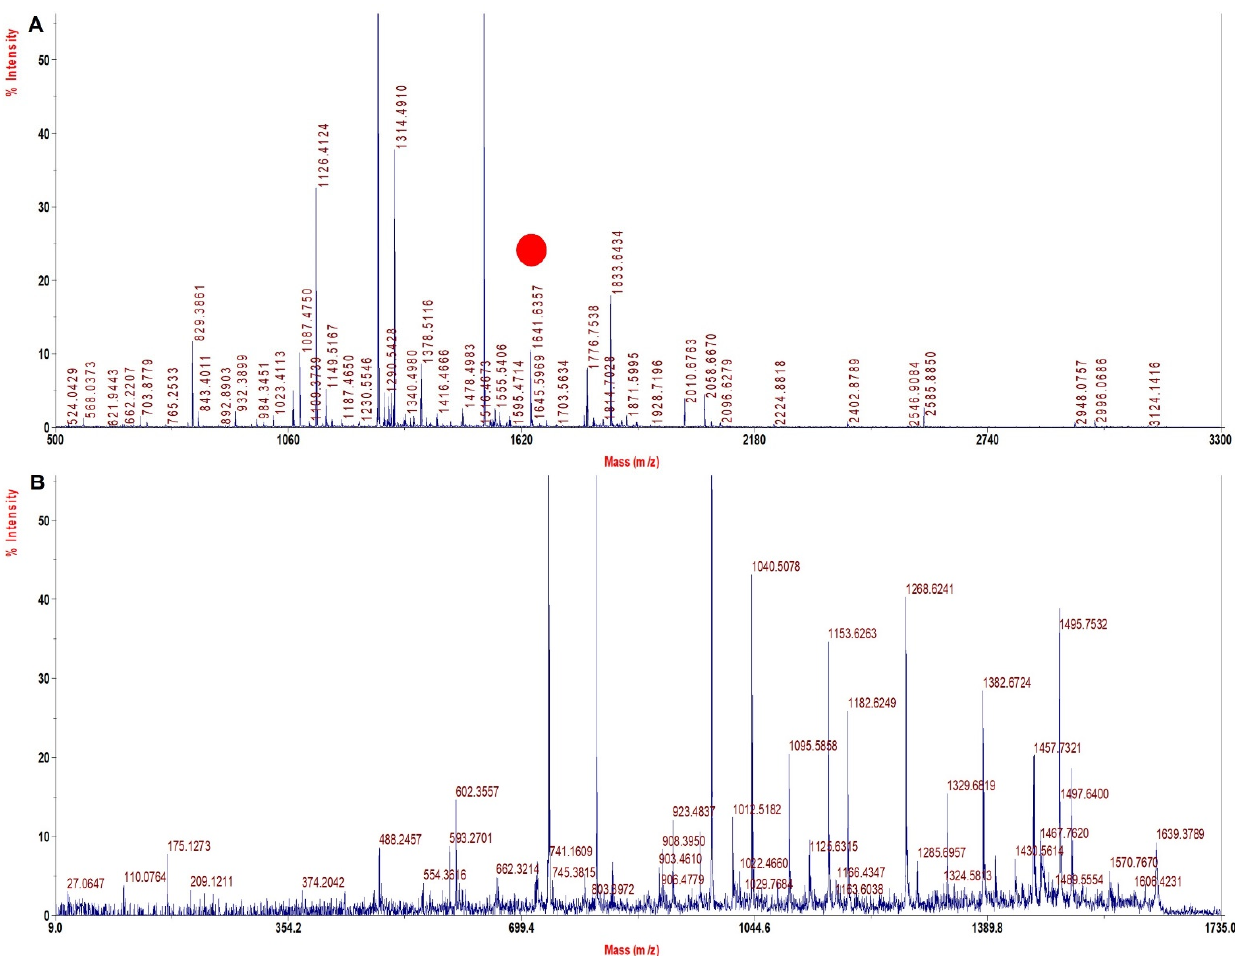
Figure 4. MALDI − MS and MALDI MS/MS spectra for the signature peptide from Mutant 3: Beta 67 (E11) Val > Ala ( A ). PMF spectrum showing signature peptide obtained by TFE treated in − solution tryptic digestion. ( B ) MALDI − MS/MS spectrum of the signature peptide of 1641.6 m/z.